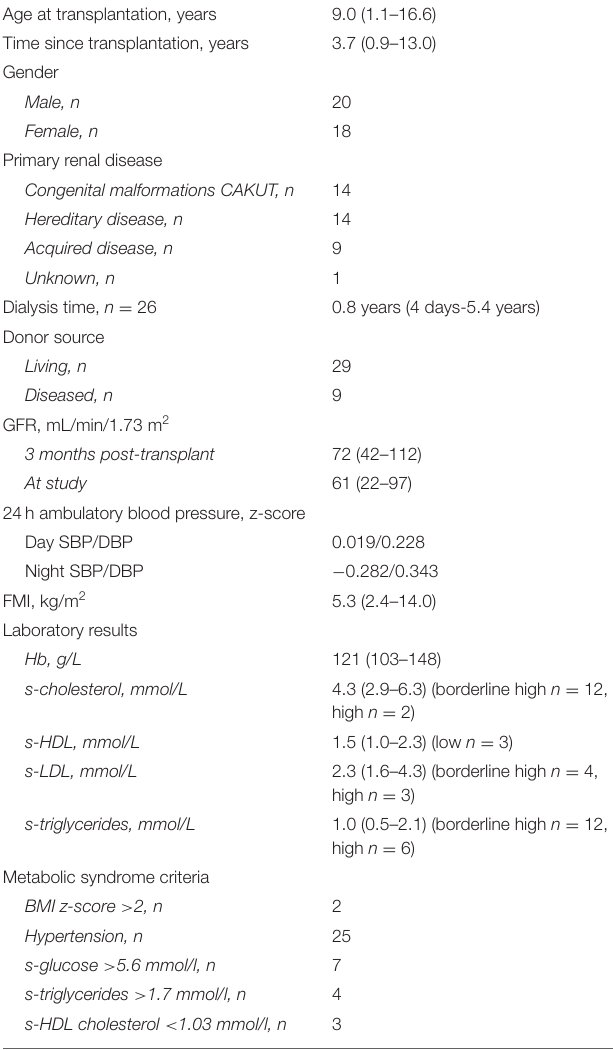
TABLE 1 | Demographic and anthropometric data on kidney transplanted children and healthy controls.